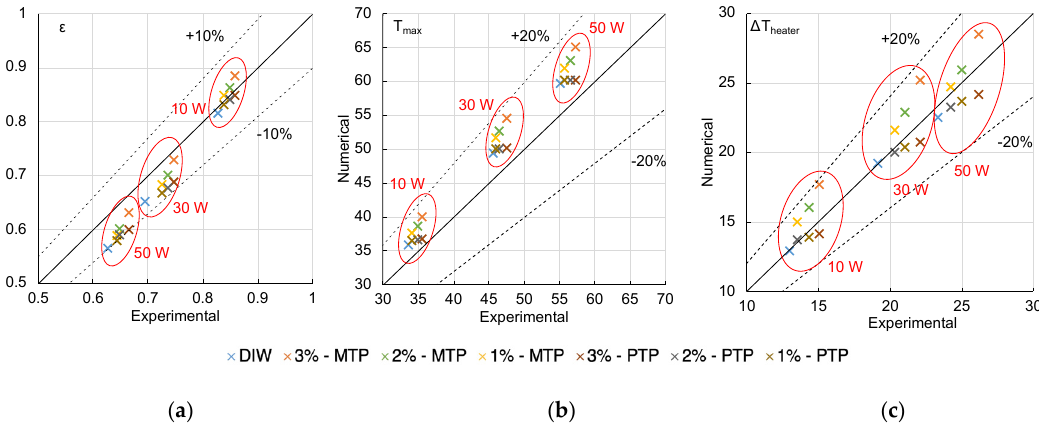
Figure 4. Comparison between the numerical model’s results with experimental values of [70,72] in